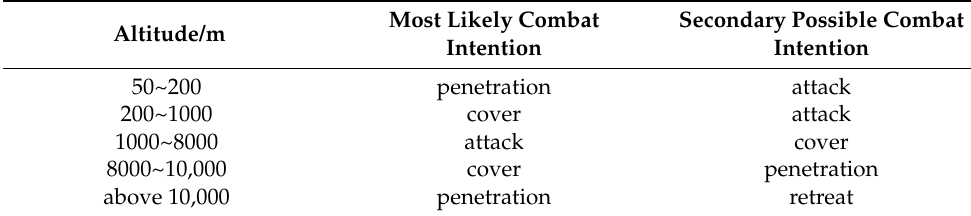
Table 1. The relationship between altitude and the combat intention of the target fighter.